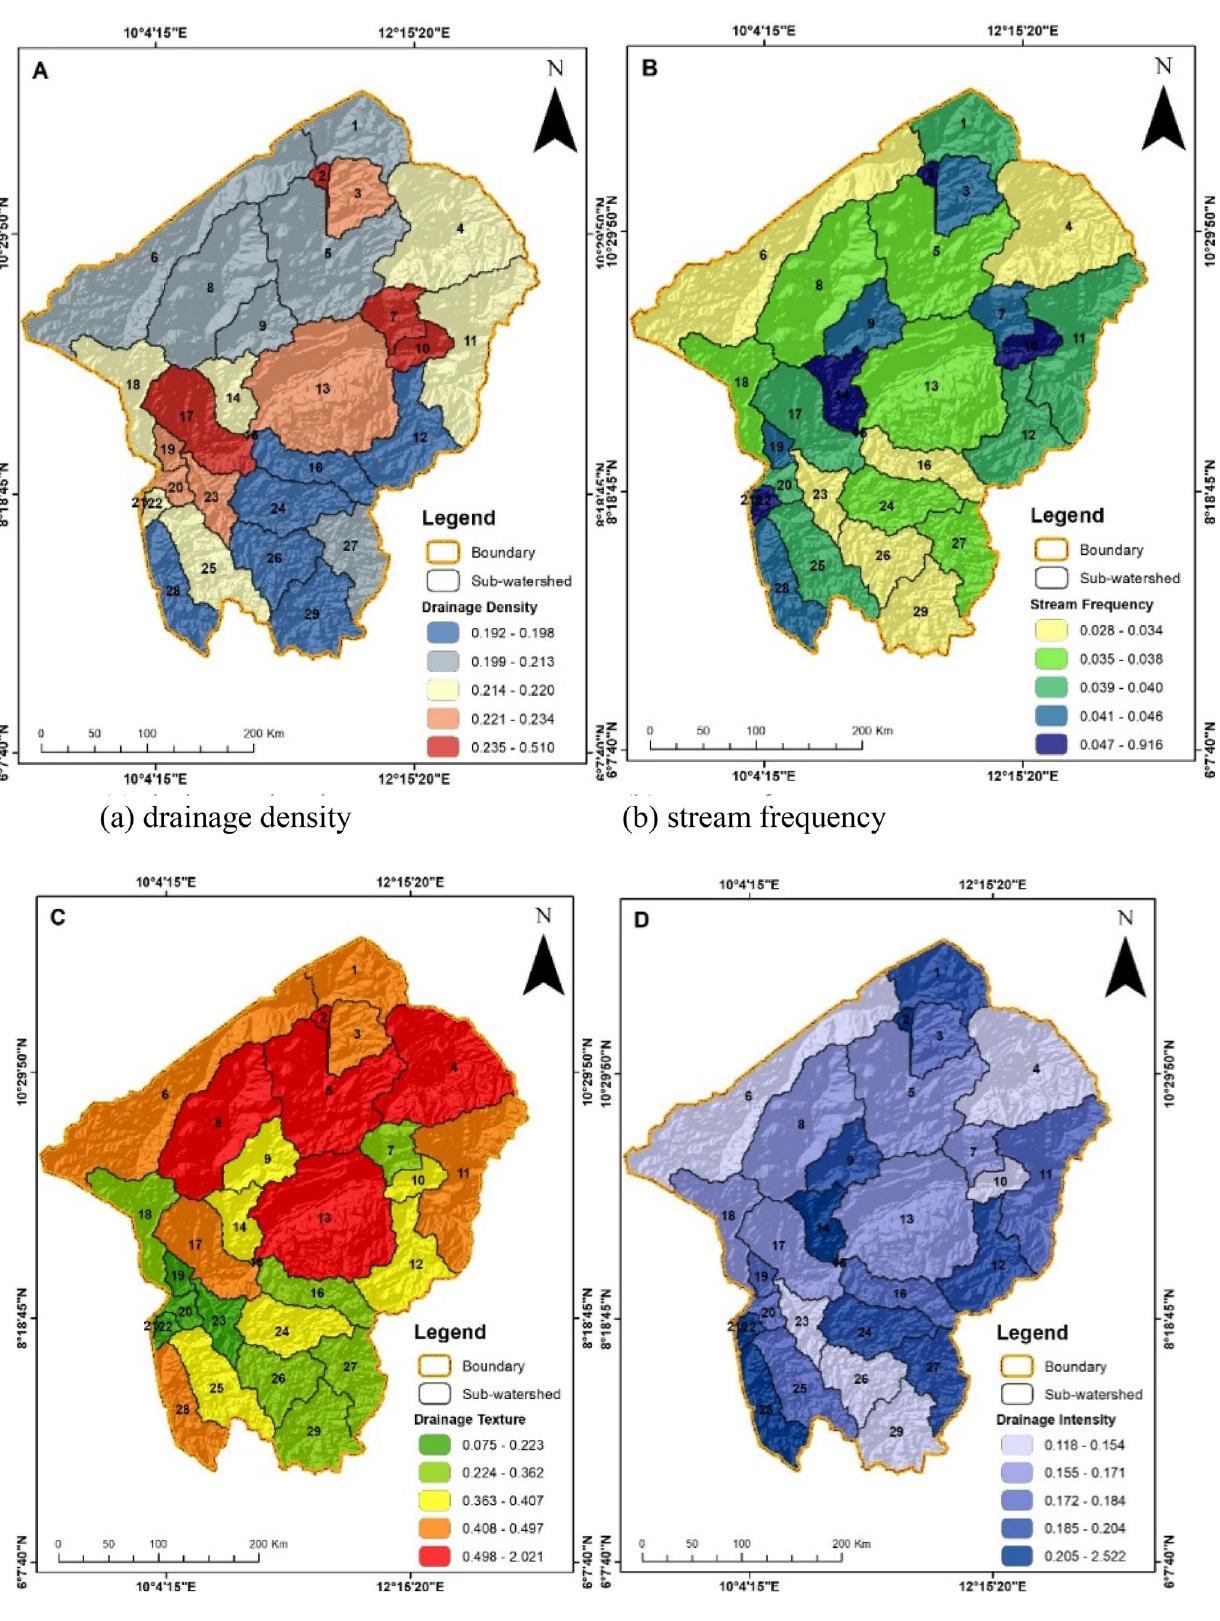
Fig. 6 a drainage density, b stream frequency, c drainage texture d drainage intensity e Infiltration number f Length overland flow, g Constant Channel Maintenance h Form Factor i Elongation ratio j Circulation